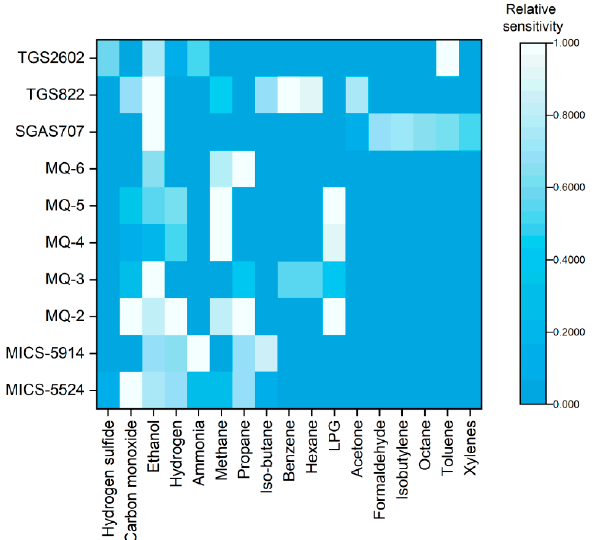
Figure 1. Comparison of relative sensitivity of 10 candidate metal-oxide sensors with respect to the detectability of 17 chemical species. Sensor selection was determined based on wider selection of chemical species with strongest sensitivities.